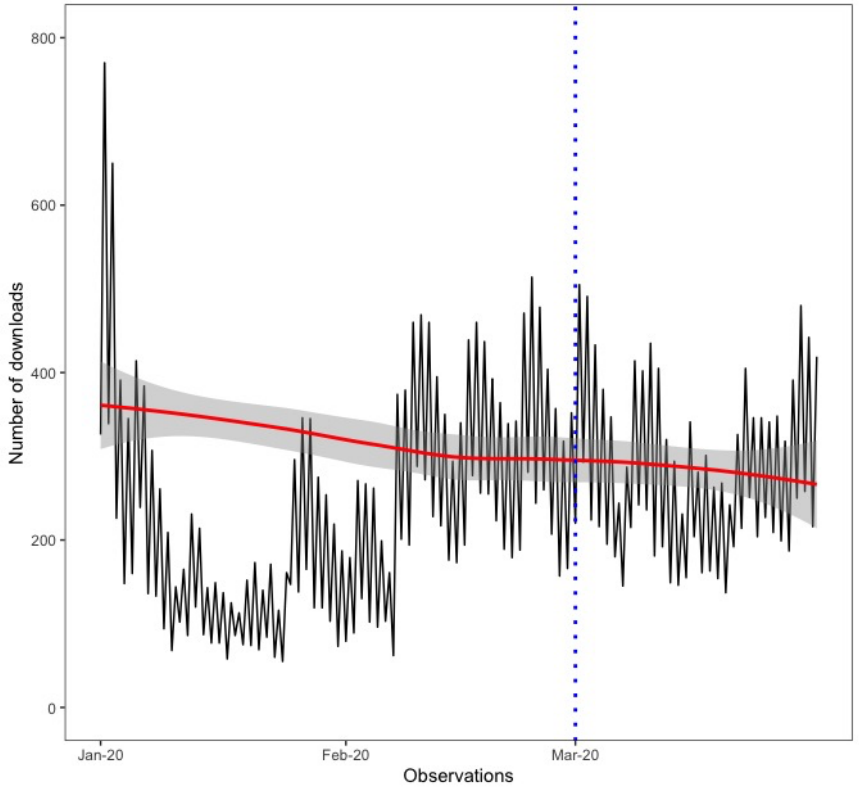
Figure 1. The number of users downloading the Smoke Free app from January 1, 2020, to March 31, 2020. The dotted blue vertical line represents the stipulated starting point of the severe acute respiratory syndrome coronavirus 2 outbreak (ie, March 1, 2020). The solid red line represents the fitted values with a loess smoothing function applied and associated 95% CIs.